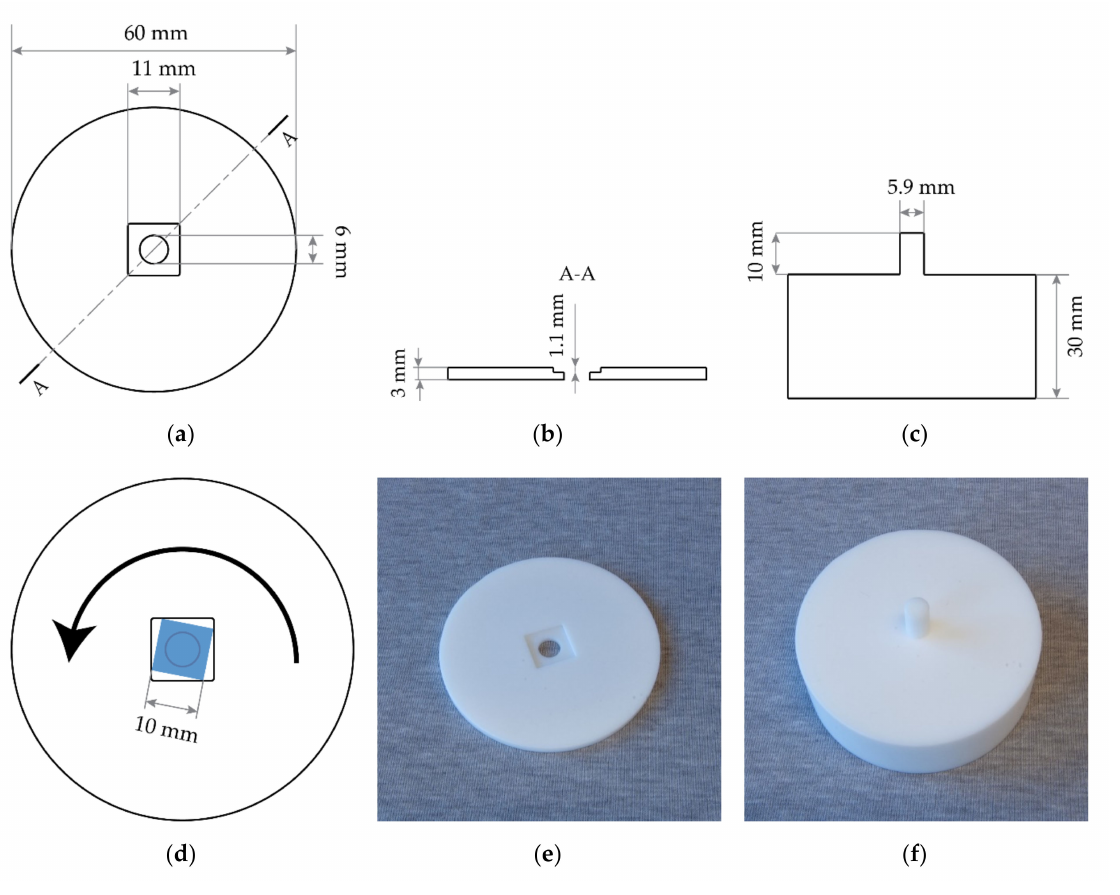
Figure 2. Technical drawing of the chuck used for edge bead-reduced spin coating. ( a ) Top view of the chuck. ( b ) Cross-section through line A-A in ( a ), showing the thickness of the chuck and depth of the recess. ( c ) Cross-section of the base plate. ( d ) Schematic of the chuck with the sample mounted, with the direction of rotation indicated. ( e – f ) Photographs of the spin coating chuck ( e ) and sample removal tool ( f